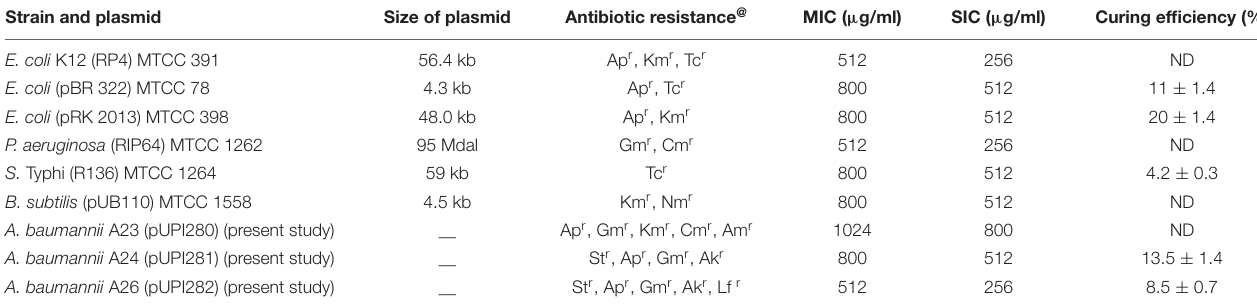
TABLE 2 | Plasmid curing with purified lawsone. Strain and plasmid Size of plasmid Antibiotic resistance